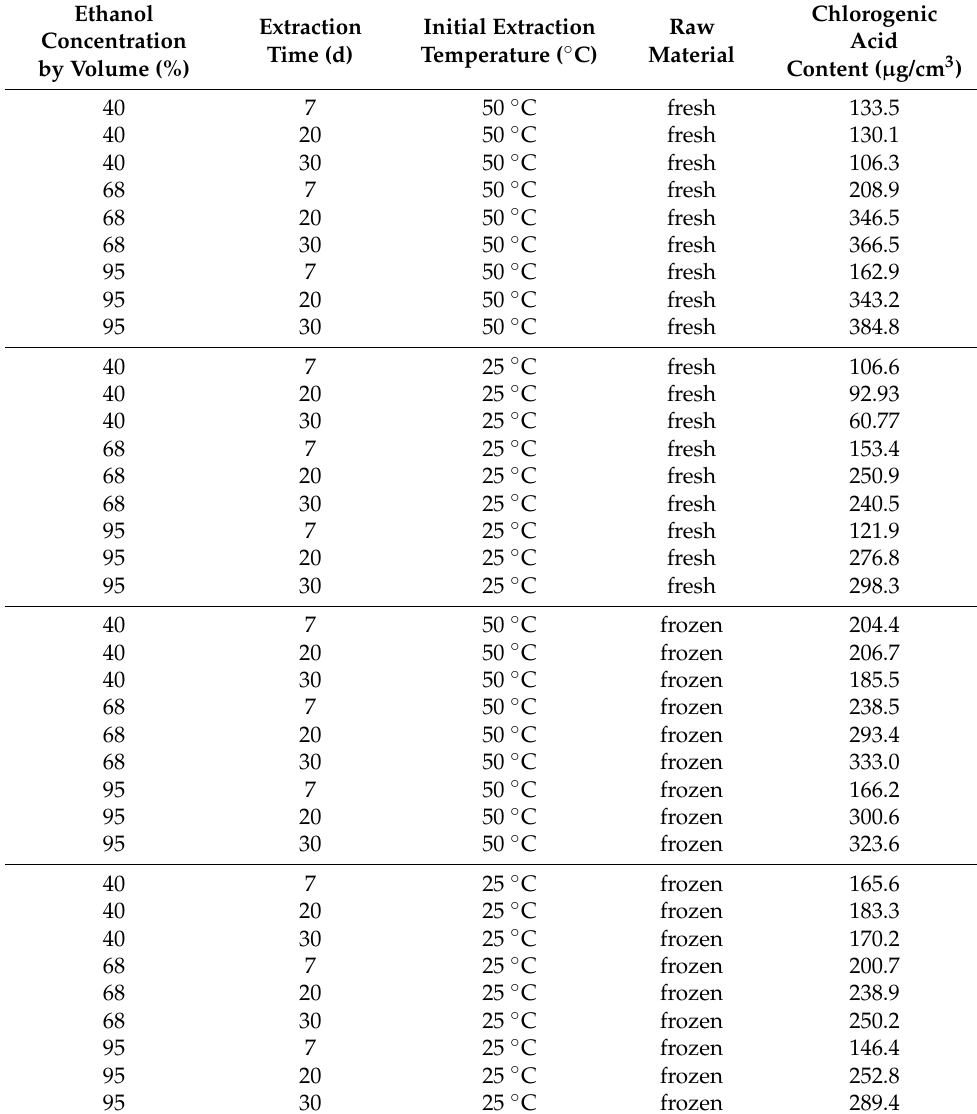
Table 1. Chlorogenic acid contents ( µ g/cm 3 ) in ethanol extracts, depending on the research variant: input data for RSM model